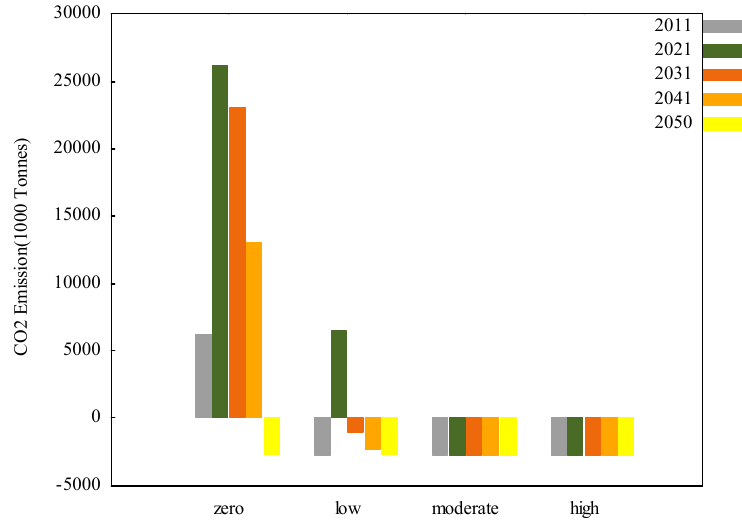
Figure 9. GHG emissions due to LUC under no subsidy action.